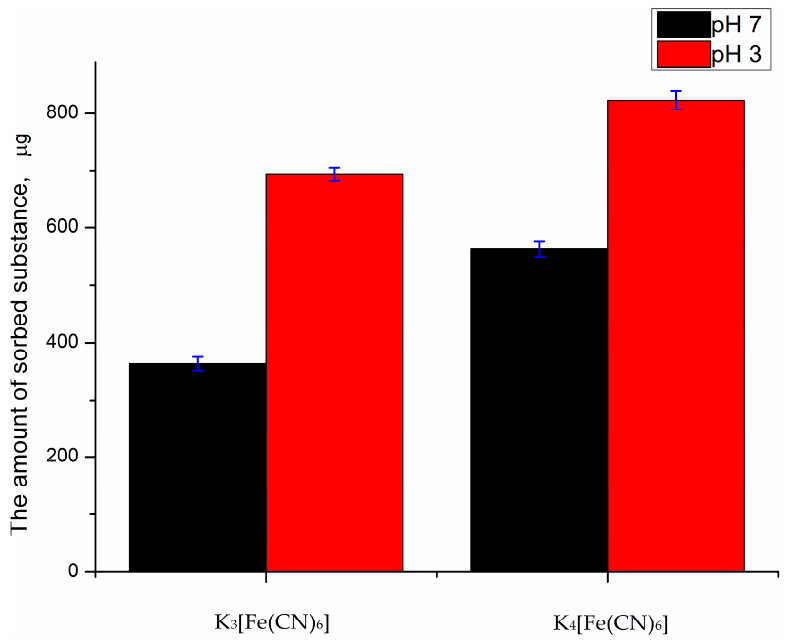
Figure 4. PMC’s (PSS/PAH) 3 sorption capacity of solutions of K 3 [Fe(CN) 6 ] and K 4 [Fe(CN) 6 ] at pH 7 and 3.